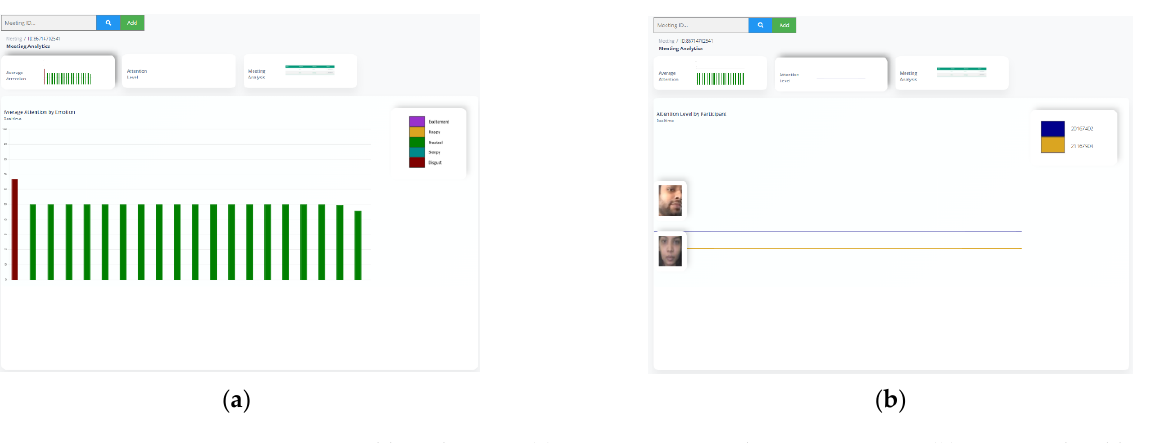
( b ) Figure 8. Confusion matrices for detection SVM models (10-fold cross-validation results): ( a ) atten- tion classification model; ( b ) face emotion classification model.